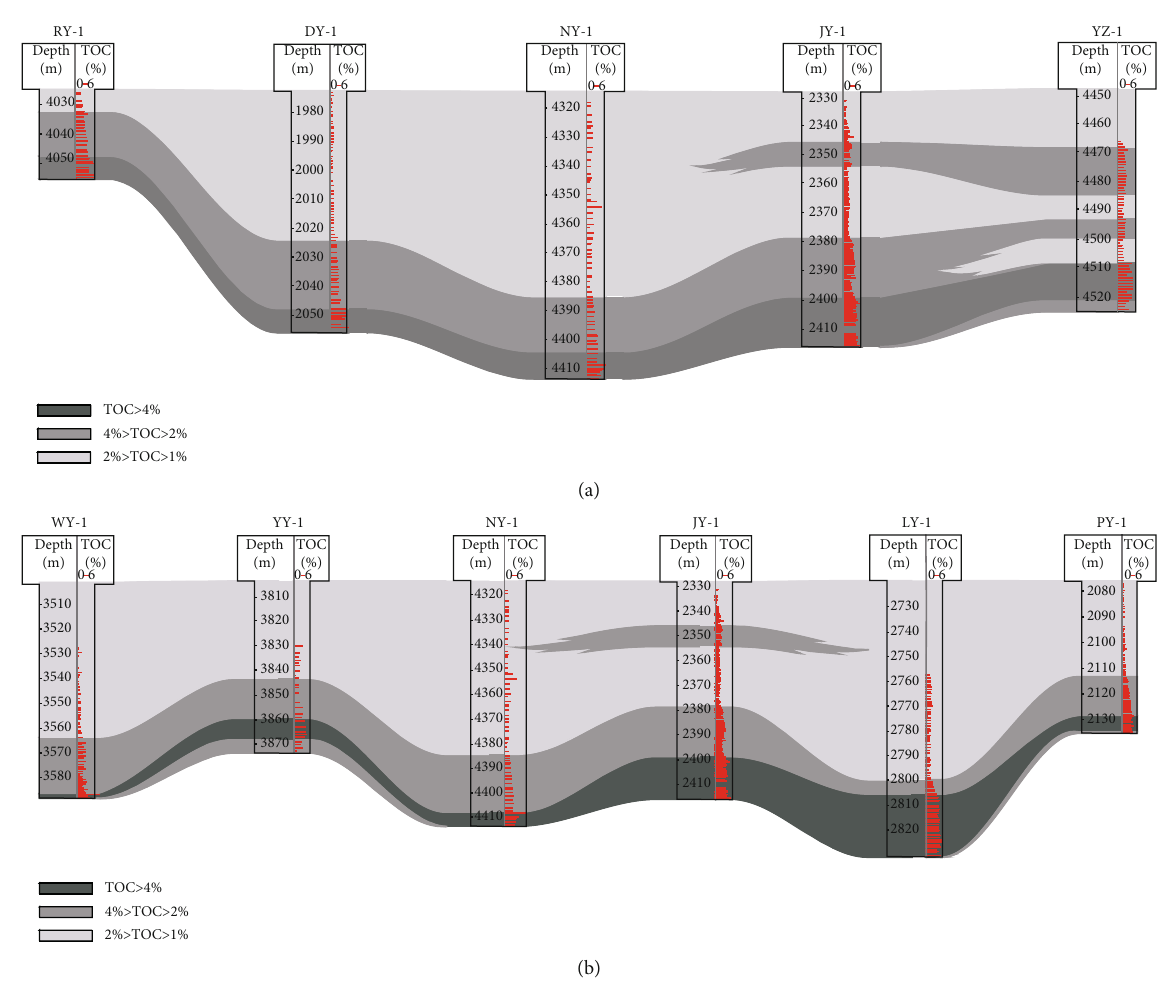
Figure 2: Comparison sections of the TOC content of the Wufeng-Longmaxi Formation shale in the southeast Sichuan Basin. (a) Section of the TOC content from northeast to southwest. (b) Section of the TOC content from east to